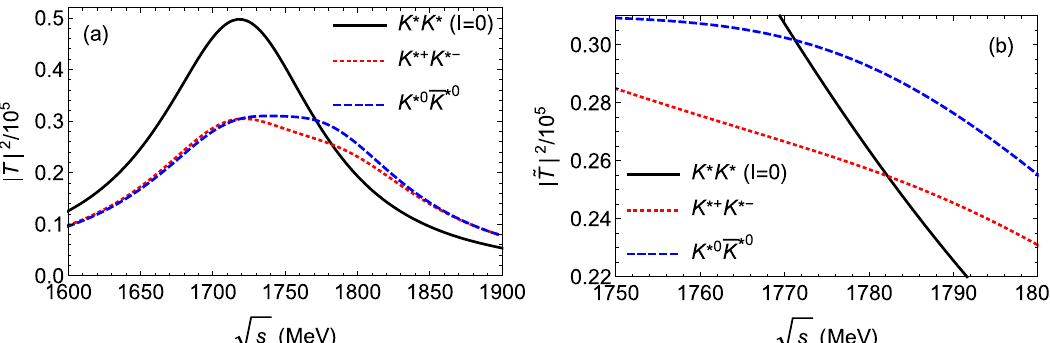
Fig. 5 a Squared modulus of ˜ T amplitudes for the channels K ∗+ K ∗− and K ∗ 0 ¯ K ∗ 0 . b Same as in a but with a zoom of a narrow energy window